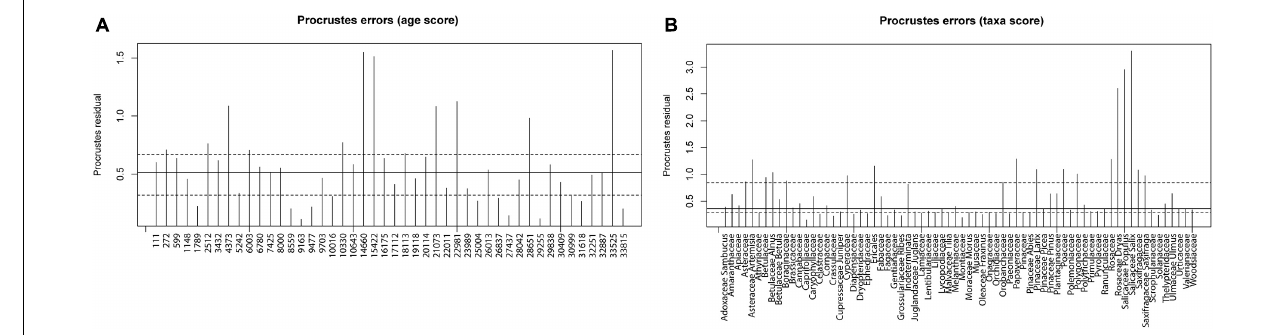
FIGURE 8 | Procrustes residuals plots. (A) Procrustes residuals plot of the comparison of principal component analysis (PCA) depth/age scores of sedaDNA and pollen data presented as residuals of depth/age scores reflecting dissimilarity between the tested datasets. Dashed lines are the first and third quartiles, while the solid line is the second quartile. (B) Procrustes residuals plot of the comparison of PCA taxa scores of sedaDNA and pollen data presented as residuals of taxa scores reflecting dissimilarity between the tested datasets. Dashed lines are the first and third quartiles, while the solid line is the second quartile.